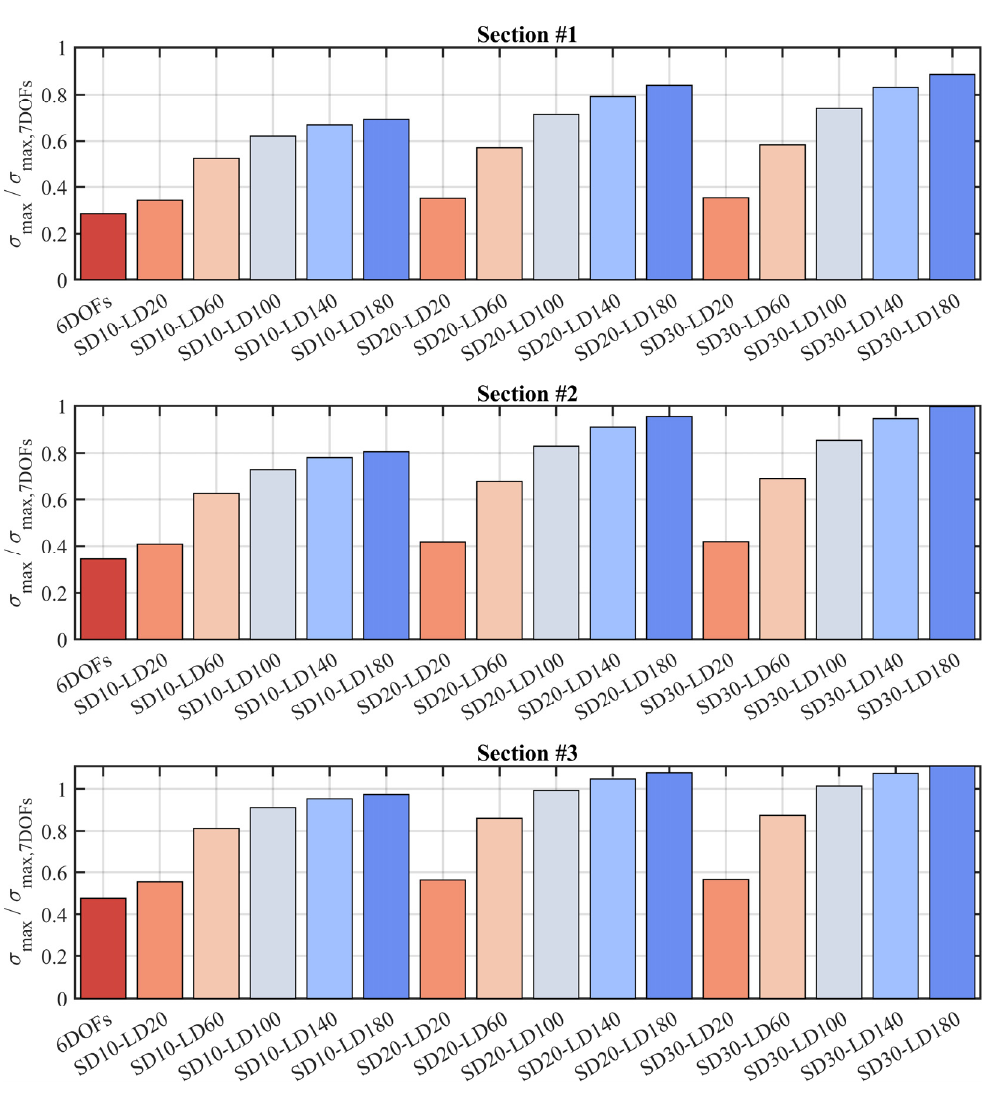
Figure 10. Distribution of the normalised stress peaks to stress peaks based on the 7DOFs formulation. The results correspond to the case with a length of 1000 mm, varying, in the case of AEM, the section discretisation (SD10, SD20 and SD30) and longitudinal discretisation (LD20, LD60, LD100, LD140 and LD180).